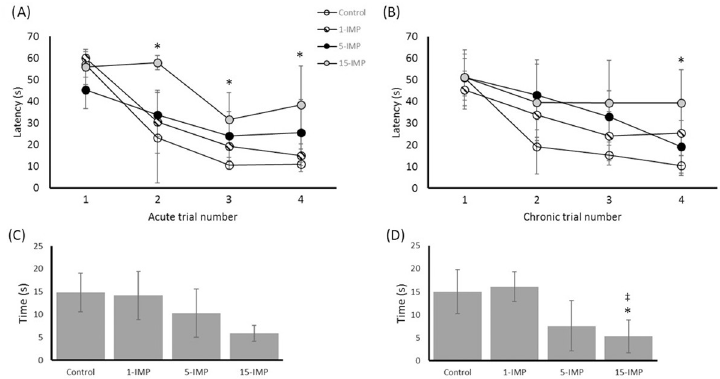
Fig 4. Repetitive mTBI impairs performance in the Morris water maze. (A) Time to find the hidden platform (seconds) in the MWM at acute testing. (B) Time to find the hidden platform in the MWM at chronic testing. (C) Time spent in the goal quadrant of the Probe Test at acute testing. (D) Time spent in the goal quadrant of the Probe Test at chronic testing. Values reported as mean ( ± SD). � p < 0.05 difference compared with sham control; ‡ p < 0.05 difference with 1-IMP; # p < 0.05 difference compared with 5-IMP. N = 4 per group.